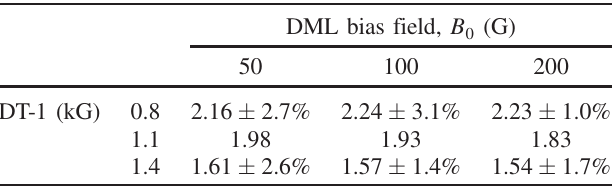
TABLE VI. Average rms radius (cm).